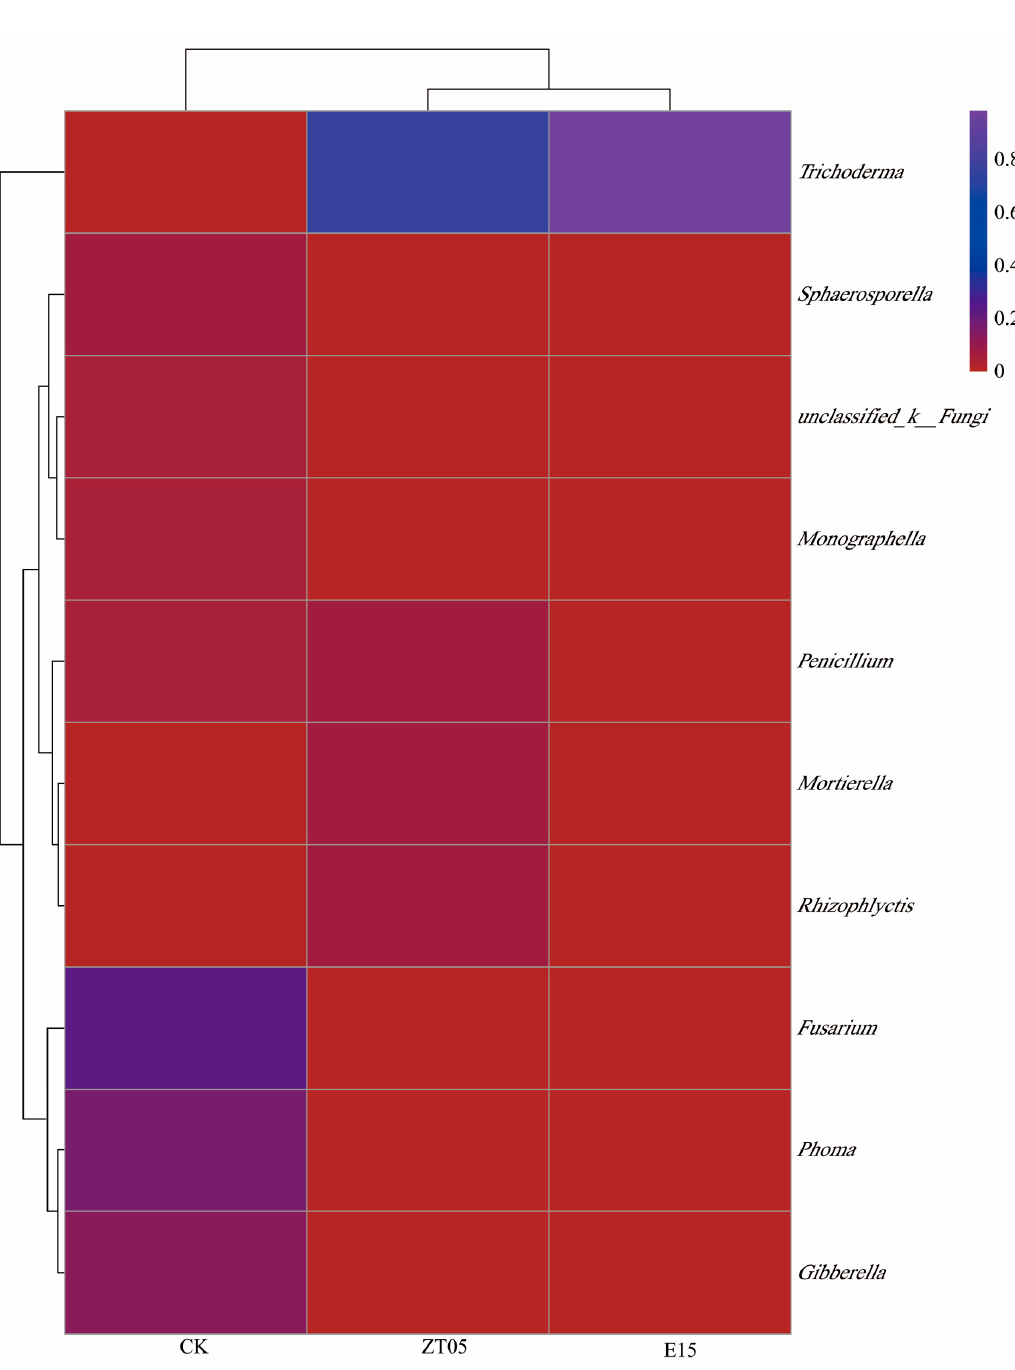
Figure 5. Heat map showed the relative abundance of the top 10 genes at CK, ZT05, E15 treatments. CK: inoculation with PD blank culture medium. ZT05: single inoculation with T. virens ZT05. E15: single inoculation with T. harzianum